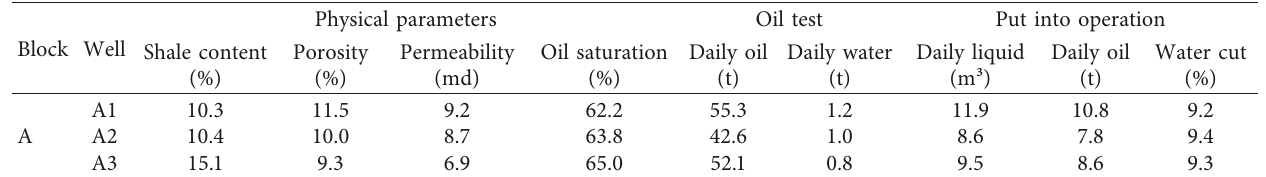
Table 7: The effect of 3 wells fractured by thickening water.